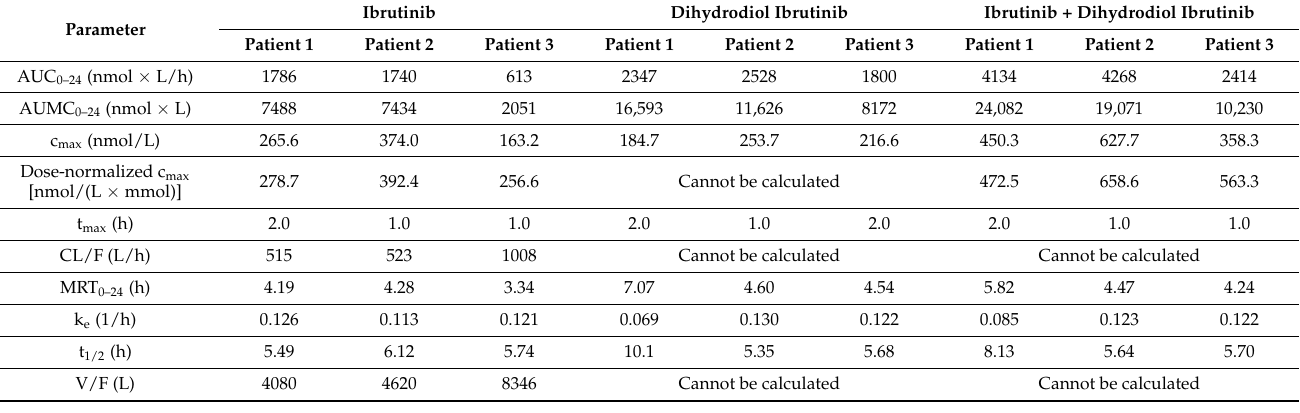
Table 5. Calculated individual pharmacokinetic properties of IBR and the active moiety (IBR + DIB). AUC 0–24 , area under the concentration–time curve from dose intake to 24 h postdose. AUMC 0–24 , area under the first moment of the concentration–time curve from dose intake to 24 h postdose. CL/F,